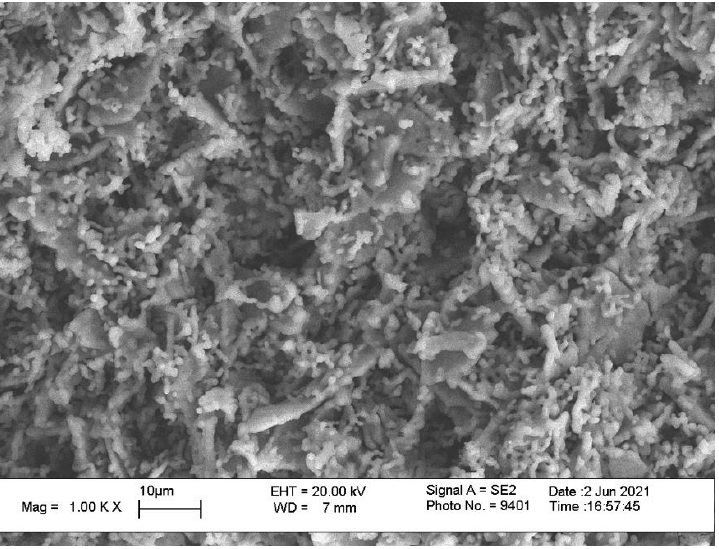
Figure 6. Micrograph of the surface of the ceramic sample based on powder mixture including brushite (calcium hydrophosphate dihydrate) CaHPO 4 ·2H 2 O, calcium oxalate monohydrate CaC 2 O 4 ·H 2 O in form of whewellite and weddellite and non-identified phase after firing at 1200 °C. Apparent density (g/cm 3 ) and relative diameter (D/D 0 , %) of ceramic samples after firing at different temperatures are presented at Figure 7. Linear shrinkage increased very slowly from 1% at 500 ◦ C up to 2.7% at 1100 ◦ C and reach the maximum of 7 % at